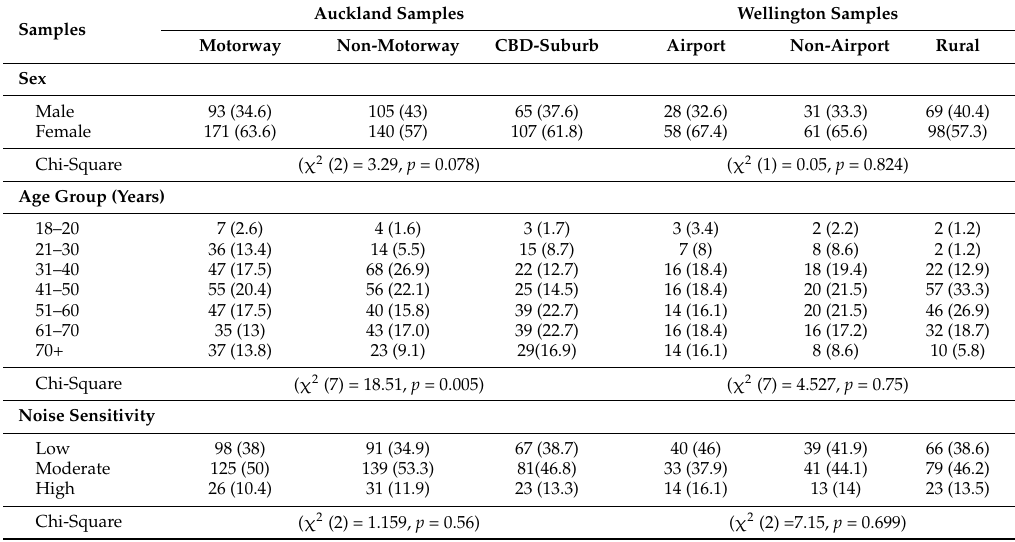
Table 1. Demographic profiles for the six samples. The values are raw frequencies with percentages presented in brackets. Note that percentages may be affected by missing data. Differences in proportions between matched samples within a dataset are tested using Pearson’s chi-square ( χ 2 )